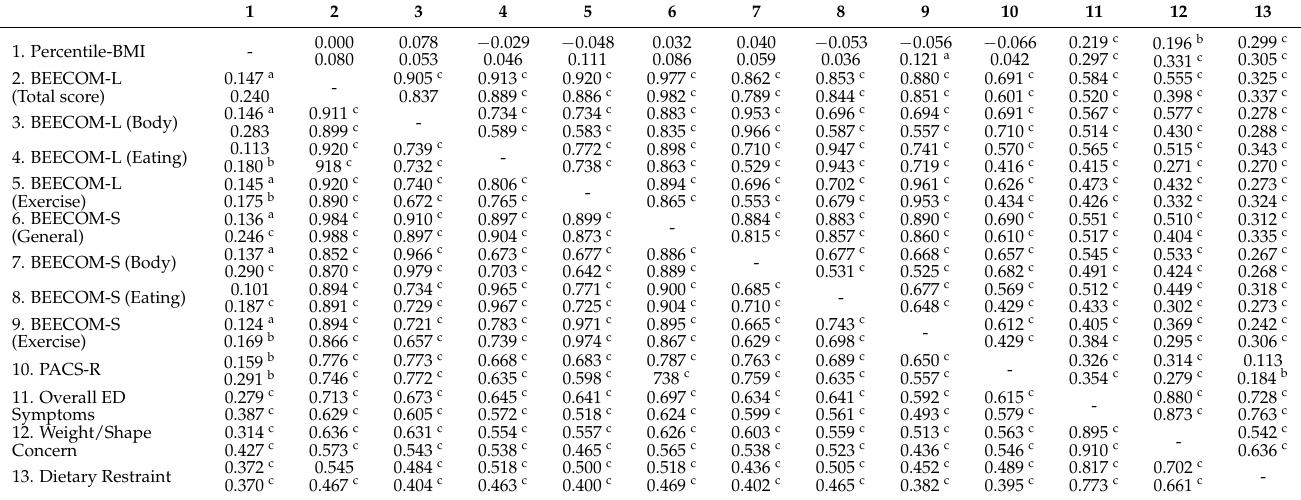
Table 4. Results of Correlational